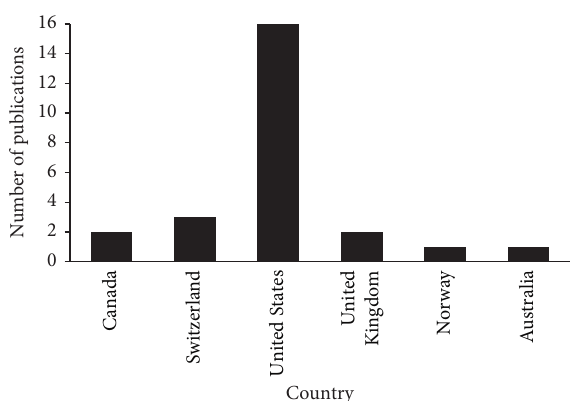
Figure 3: Countries in which the selected studies were conducted ( n �